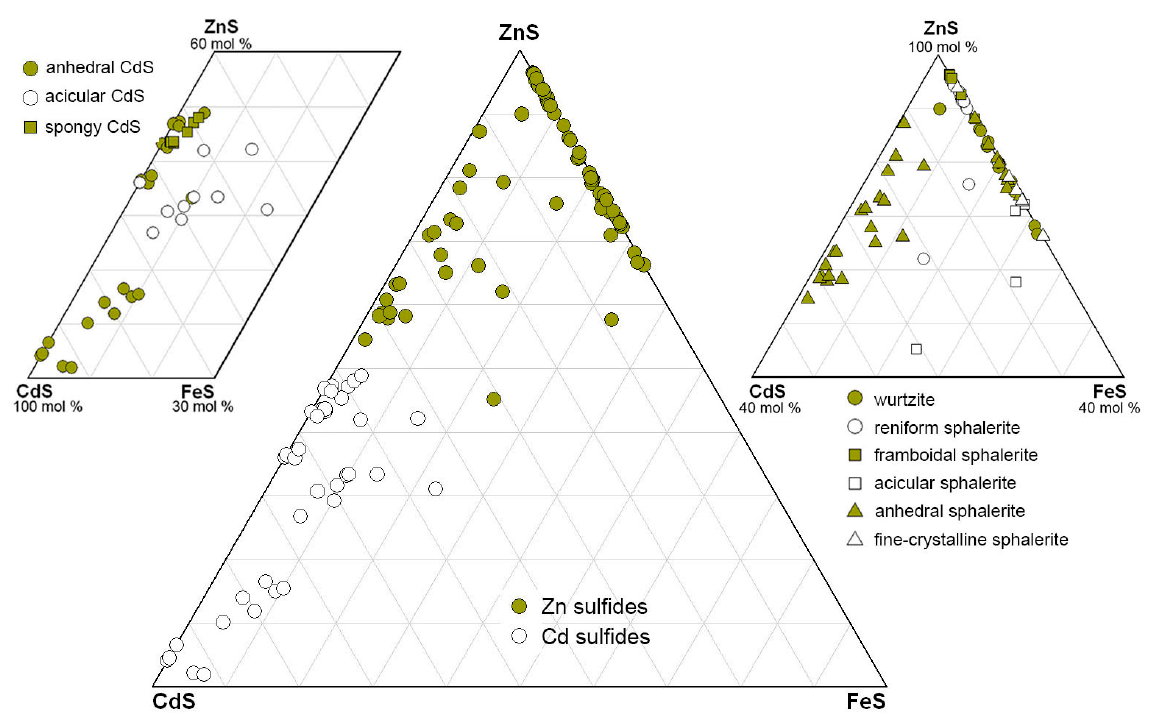
Figure 13. Compositional ranges of Zn and Cd sulfides from Zn-rich smoker chimneys of the Irinovskoe HSF.